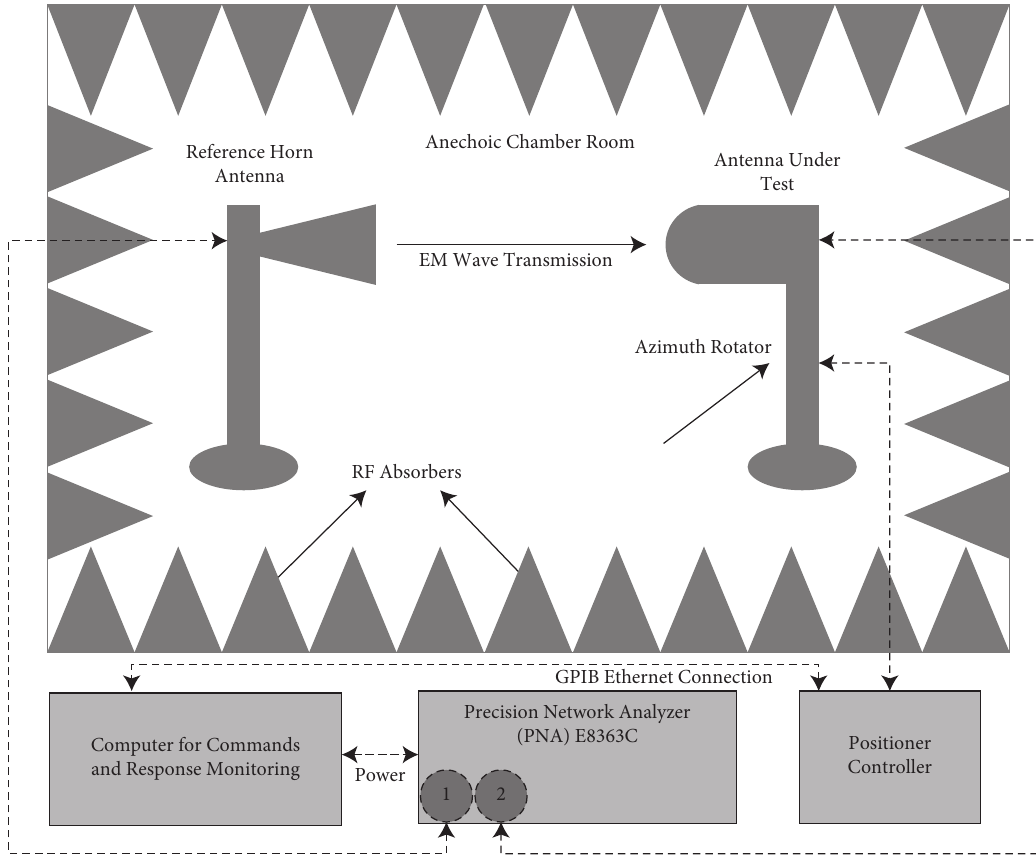
Figure 8: Block representation of the far-field measurement